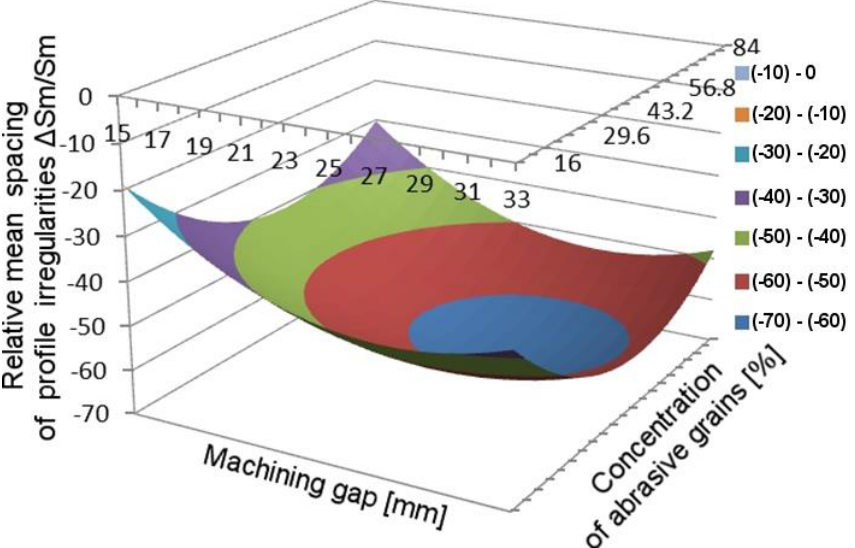
Figure 29. The impact of machining gap width and concentration of abrasive grains, at constant processing time ( T = 15 min), on relative change in roughness Δ Sm / Sm (correlation coefficient R = 0.74).